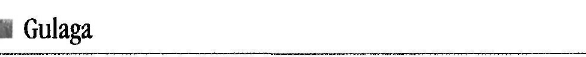
Figure 1. South coast of New South Wales (The Australian National University,